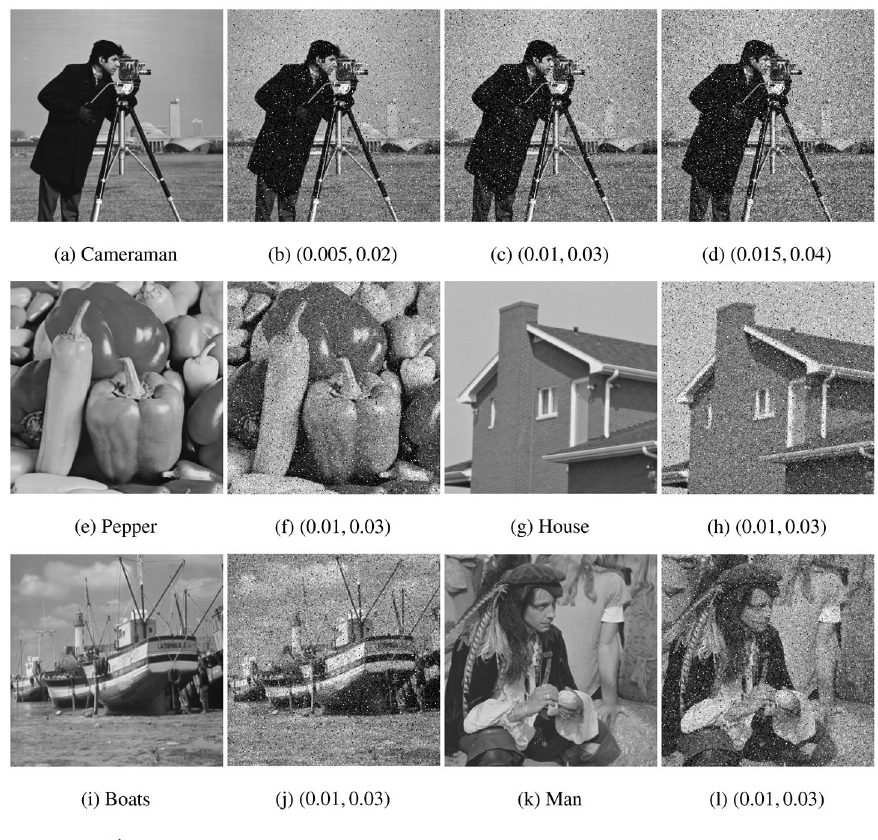
Figure 6. The test images.